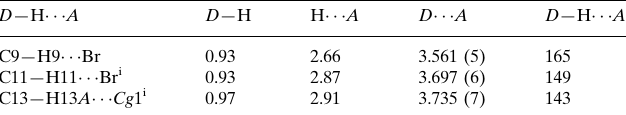
Hydrogen-bond geometry (A˚ , (cid:3)